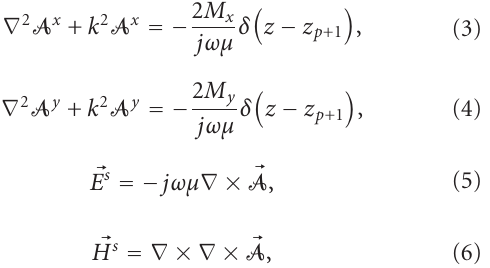
(cid:2) E ( R where the scattered field i ) s is totally due to the magnetic currents at the bottom interface, since there is no top inter- face for region R 0 . In other